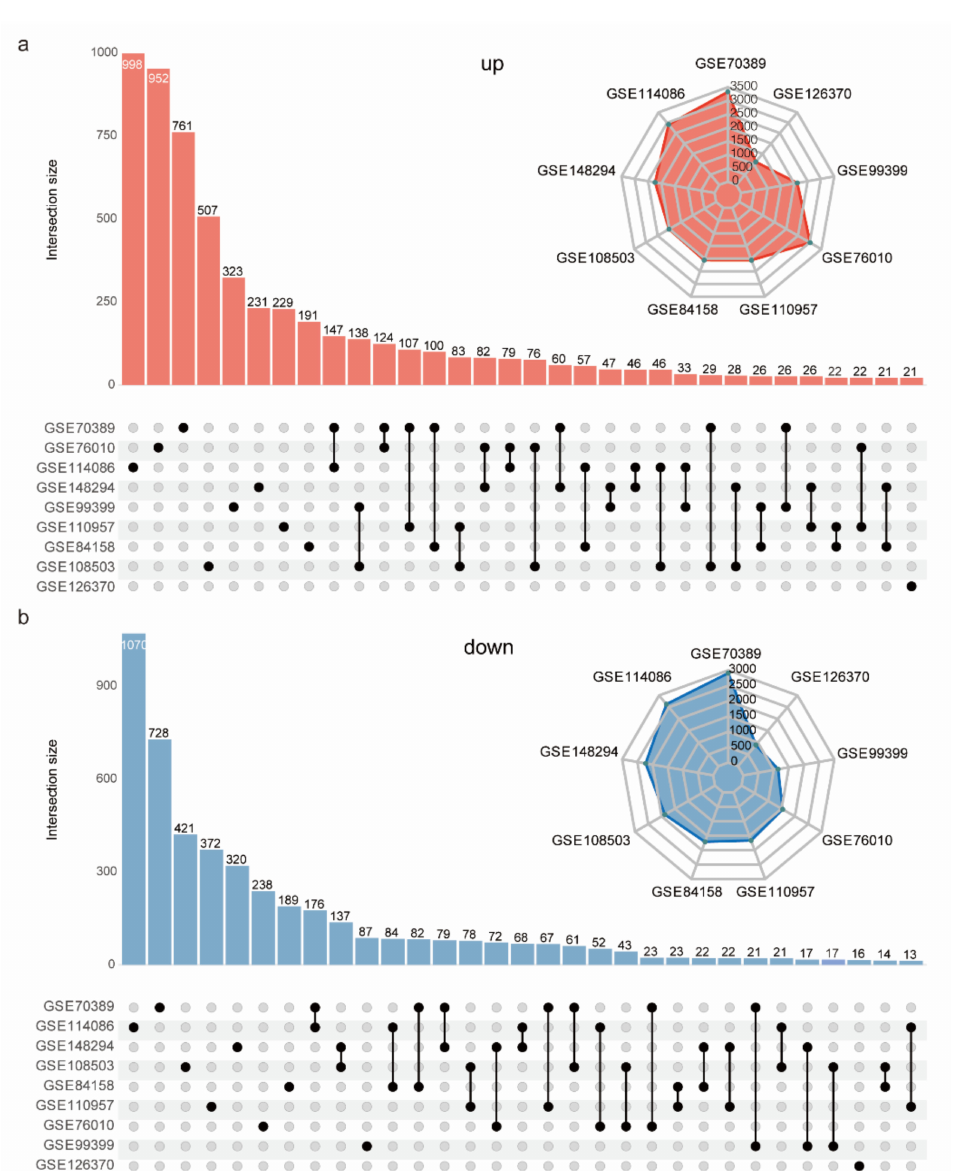
Figure 2. Intersection of DEG lists from 9 RNA-Seq datasets. The number of upregulated ( a ) and downregulated ( b ) genes in the 9 DEG lists (radar plot in the upper-right corner). The respective intersections of upregulated genes ( a ) and downregulated genes ( b ) (multidimensional Venn figure plotted with the ComplexUpset R